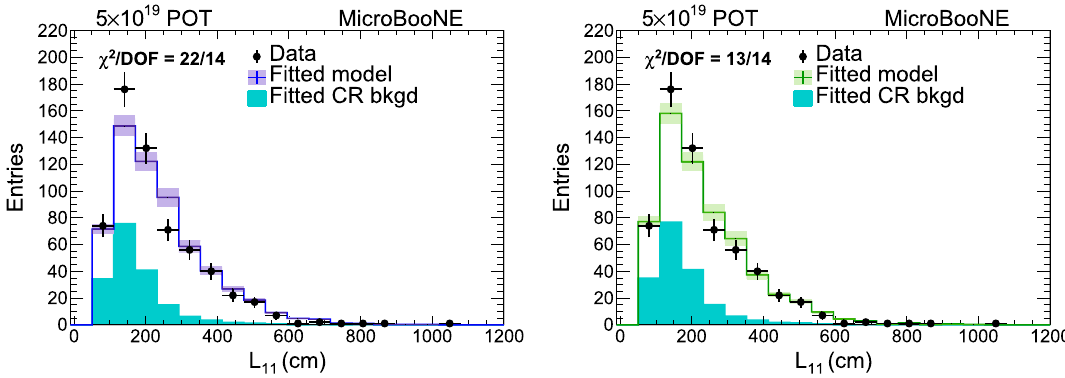
Fig. 15 Multiplicity = 1 candidate muon track length distribution using GENIE + MEC model (left); using GENIE + TEM model (right) from neutrino-enriched